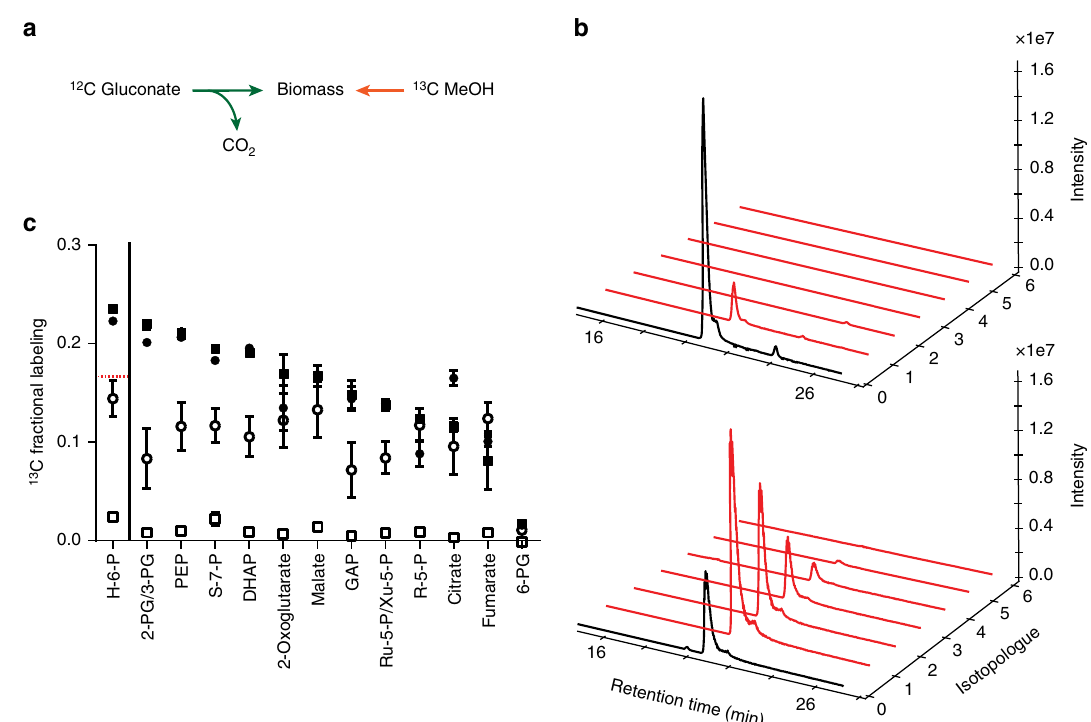
Fig. 5 Incorporation of 13 C methanol during exponential growth. a Illustration of biomass formation from unlabeled gluconate and 13 C methanol. b Isotopologue distribution of hexose 6-phosphate in an E. coli wild-type strain containing mdh and hps phi (top) and MeSV2.2 (bottom). c Labeling detected in MeSV2.2 without yeast extract (closed squares) and MeSV2.1 grown with additional 0.1 g L − 1 unlabeled yeast extract (closed circles) are shown. For comparison, the results of E. coli wild type containing mdh and hps phi without yeast extract (open squares) and with 0.1 g L − 1 unlabeled yeast extract (open circles) are provided. Data presented as mean ± standard deviation; n = 3. The red dotted line represents the expected labeling fraction under equimolar consumption of gluconate and